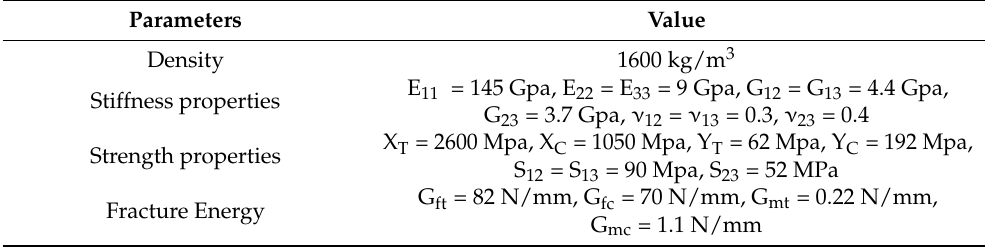
Table 1. Material properties of continuous CFRP laminate.